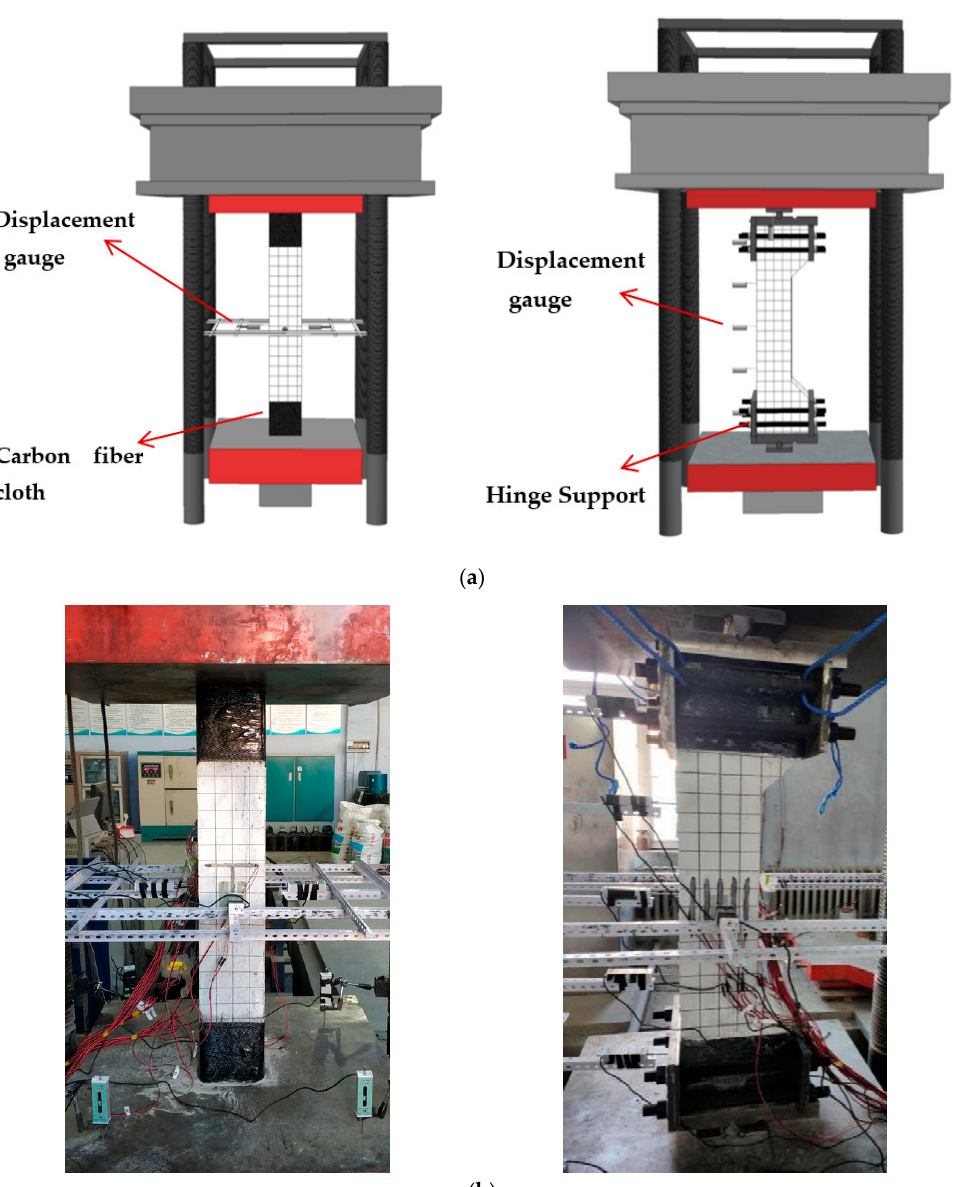
Figure 3. ( a ) A schematic and ( b ) photo of the loading device.